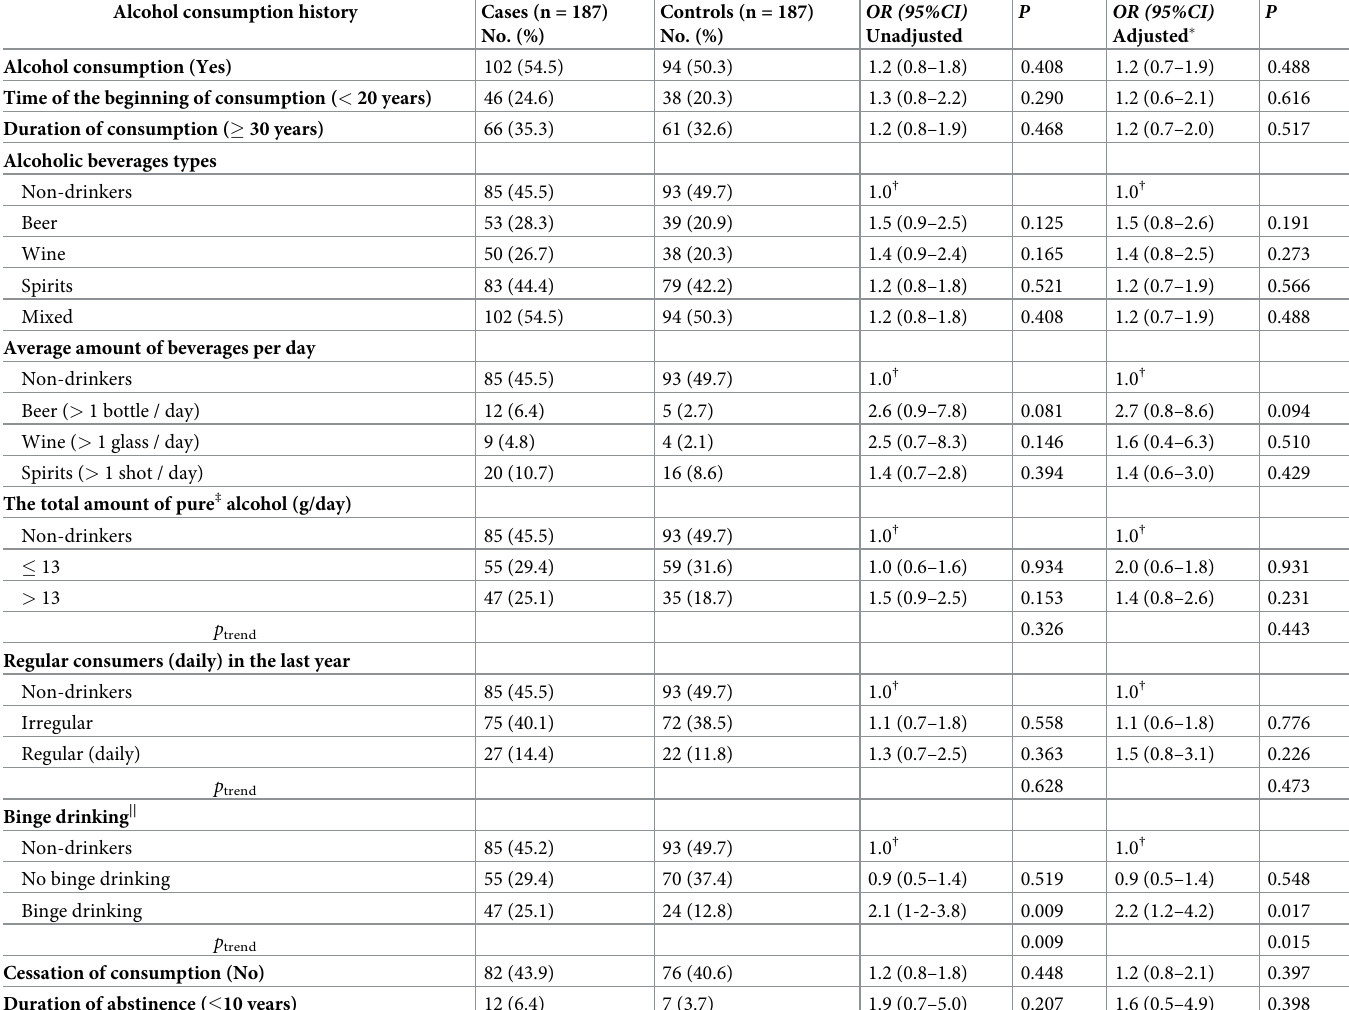
Table 3. Characteristics of study participants according to drinking